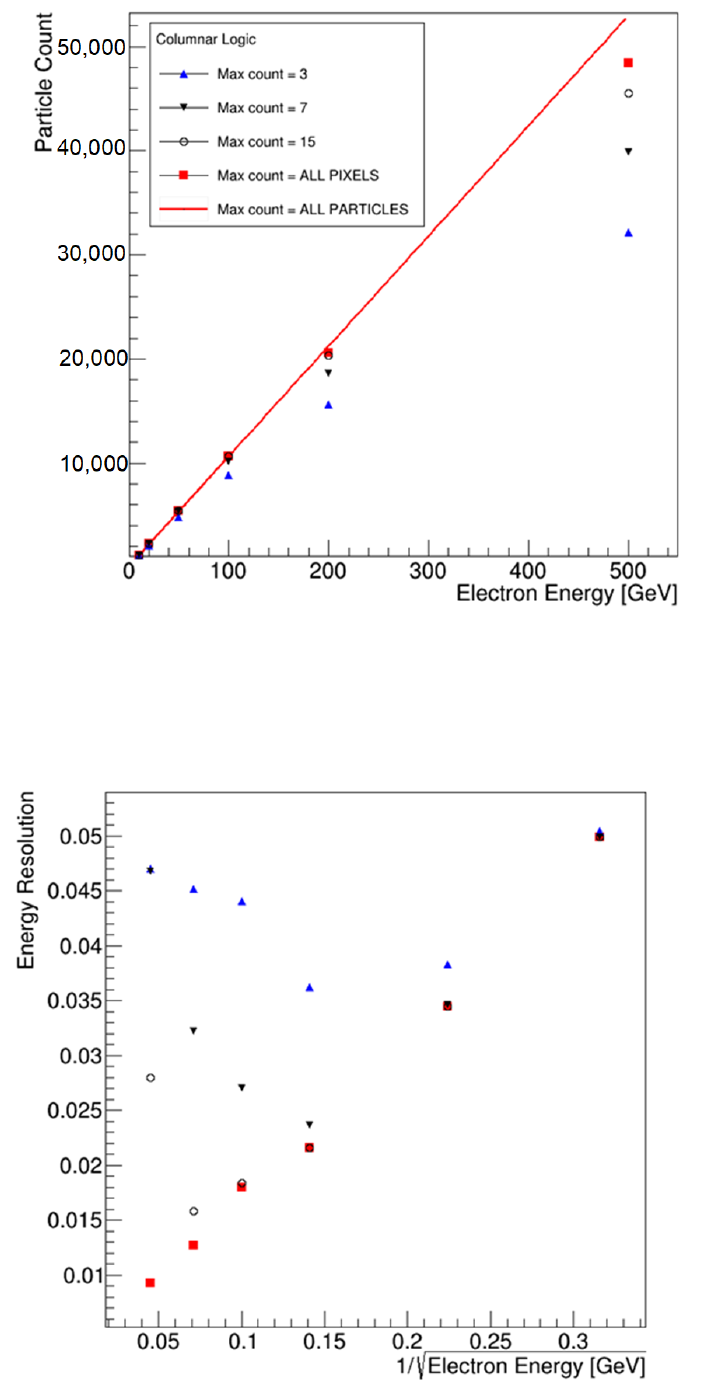
Figure 1. Study of achievable energy resolution for varying limits imposed on the maximum particle count per column. The upper plot shows the total number of particles counted for a range of detector configurations for the same incident particle energy. The lower plot shows the resulting energy